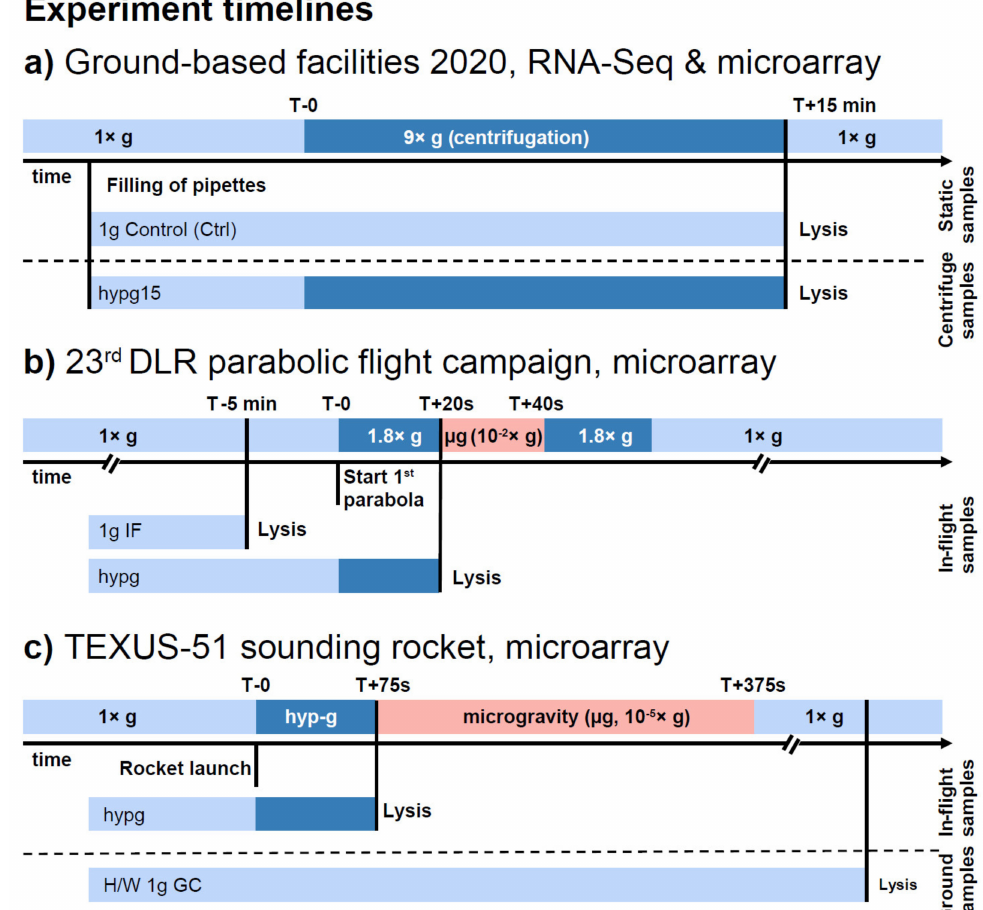
Figure 4. Experiment timelines of all data sets utilized in the short-term hypergravity cross-data-set study. ( a ) Ground-based facility study investigating the differential gene expression in human Jurkat T cells after 15 min of hypergravity exposure at 9 × g . The same set of samples was analyzed by RNA-Seq and microarray and the results of the two technologies were compared. ( b ) During the 23rd DLR parabolic flight campaign, human Jurkat T cells were exposed to 20 s of hypergravity and 20 s of microgravity, respectively. The differential gene expression was analyzed by microarray technology. ( c ) During the TEXUS-51 sounding rocket campaign, human Jurkat T cells were exposed to 75 s of hypergravity and 5 min of microgravity. Transcriptomics analyses were performed by microarray